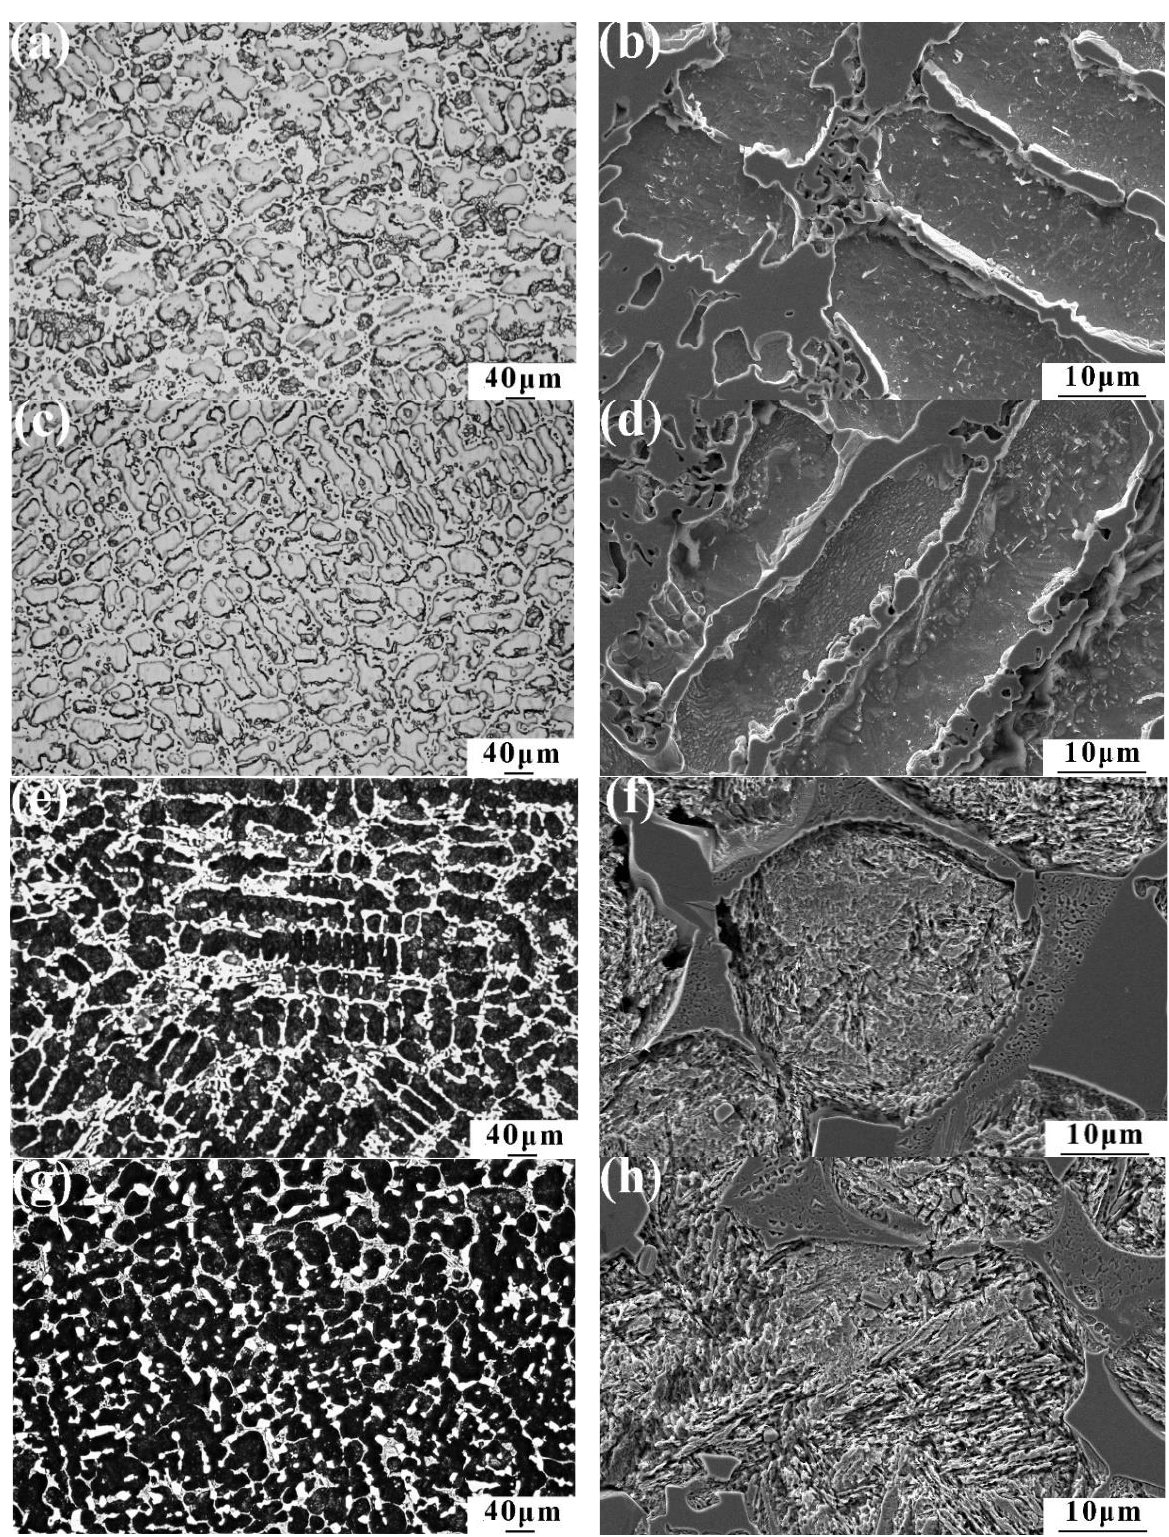
Figure 4. Microstructures of alloy A quenched at different temperature ( ◦ C): ( a , b ) 960; ( c , d ) 1000; ( e , f ) 1040; ( g , h ) 1080.